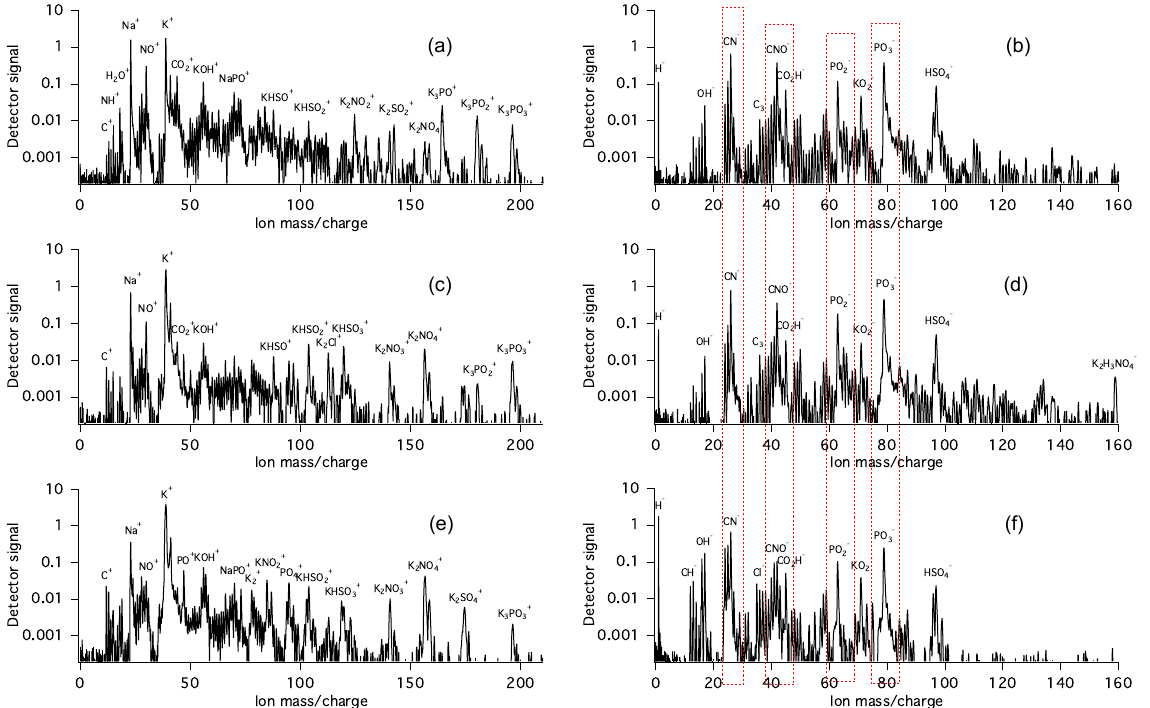
Figure 1. Representative PALMS spectra of bioaerosol. (a, b) Snomax. (c, d) P. syringae . (e, f) Hazelnut wash water. Right and left columns are positive and negative polarity, respectively. Red dotted lines are features indicated in the literature as markers for biological material.